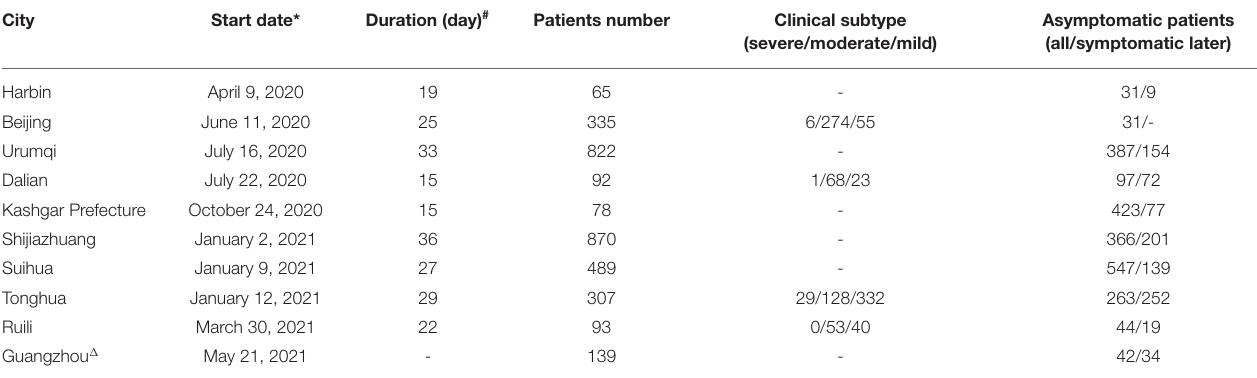
TABLE 1 | Basic information of patients in different outbreaks. City Start date* Duration (day) # Patients number Clinical subtype